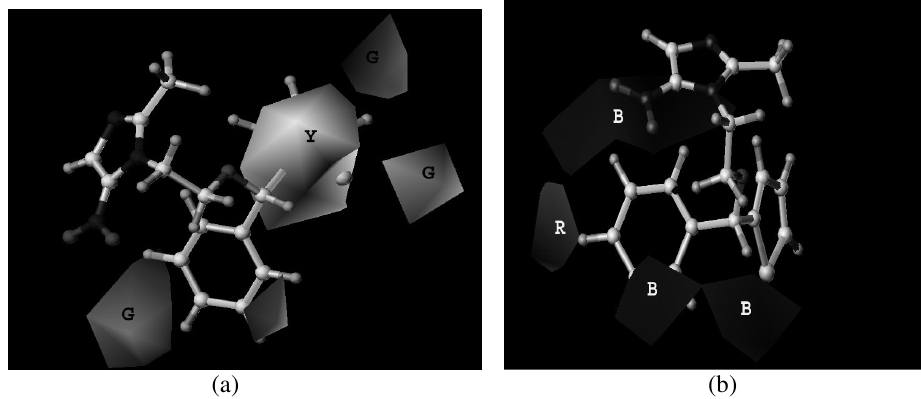
Figure 7 . The CoMSIA steric (a) and electrostatic (b) contour maps. One of the most active molecules 15 is shown in the background. Red (R) colour is a negative charged region, blue (B) a positively charged region, green (G) a positive sterically active region, and yellow (G) a negatively sterically active